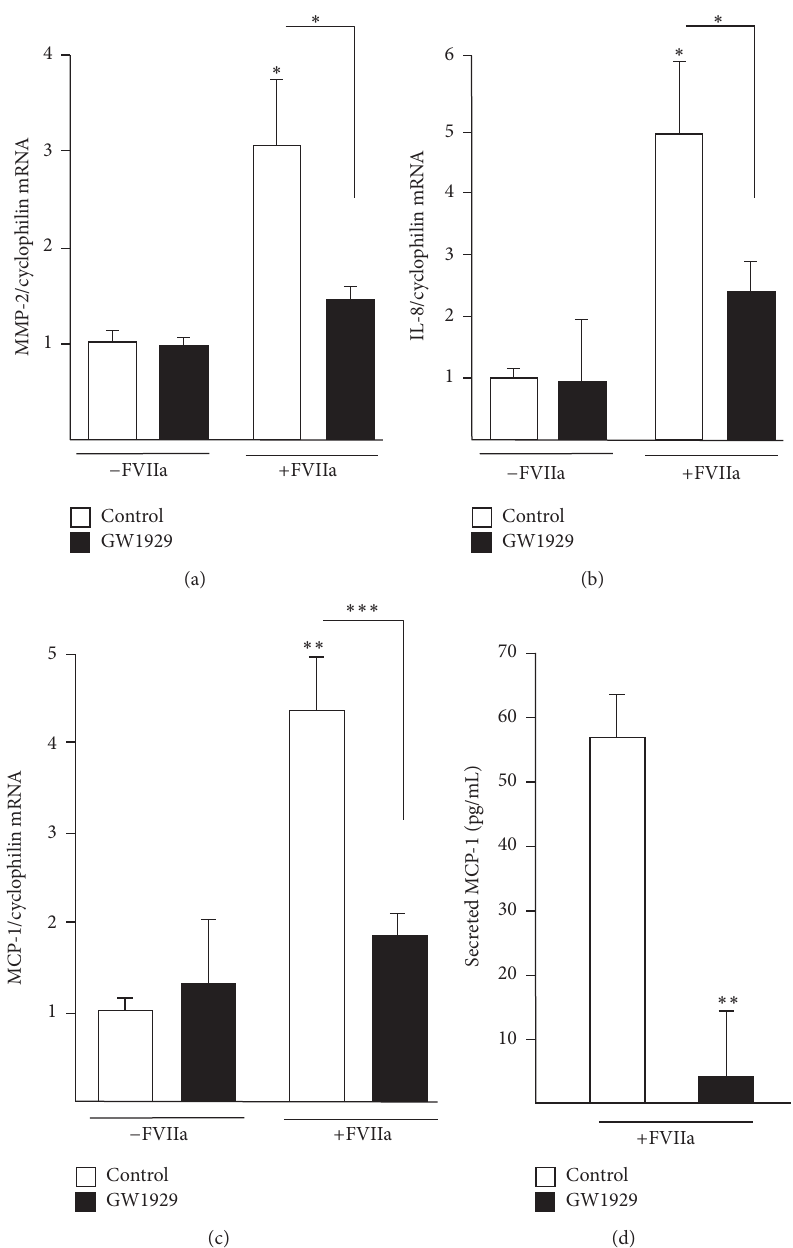
Figure 5: PPAR 𝛾 activation blocks the FVIIa-induced inflammatory response in primary human macrophages. Differentiated macrophages weretreatedwithGW1929(24 h,600 nM),washedandthenincubatedintheabsenceorinthepresenceofFVIIa(10 nM)forfurther24h.Total RNA was extracted and MMP-2 (a), IL-8 (b), and MCP-1 (c) mRNA levels were measured by Q-PCR and normalized to those of cyclophilin. Secretion of MCP-1 was measured by ELISA in culture medium (d). Results are expressed as the mean value ± SD of triplicate determinations, representative of three independent experiments. Statistically significant differences are indicated ( ∗ 𝑝 < 0.05 , ∗∗ 𝑝 < 0.01 , and ∗∗∗ 𝑝 < 0.001